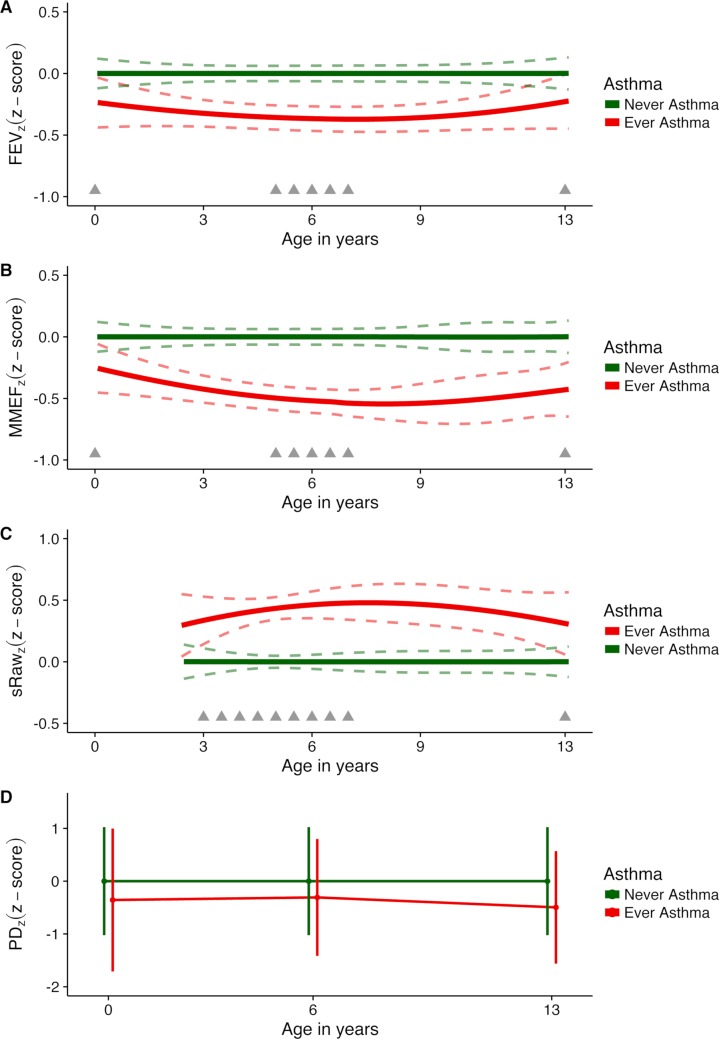
Development of z-scored measures of lung function and bronchial reactivity from 1 month to 13 years.z-Scores for (A) forced expiratory volume (FEVz), (B) maximal mid-expiratory flow (MMEFz), (C) specific airway resistance (sRawz), and (D) provocative dose of methacholine (PDz). Dashed lines represent 95% confidence intervals; grey triangles indicate timing of measurements. The vertical bars in (D) indicate the exact distribution in terms of age of sampling of the raw data.